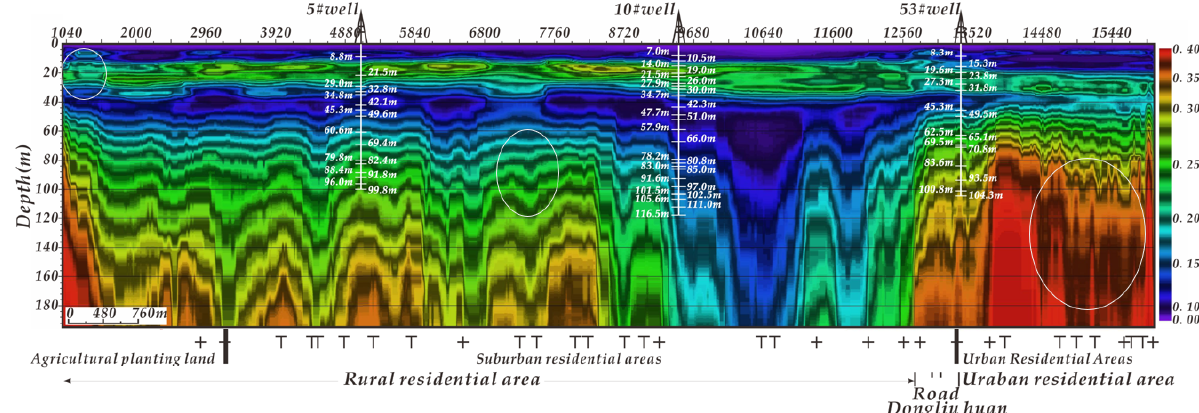
Figure 7. The formation density information of Tongzhou subsidence typical area acquired by SFR, while the white circle shows the typical region that the human activities caused the reduction in stratigraphic density in urban and rural areas.